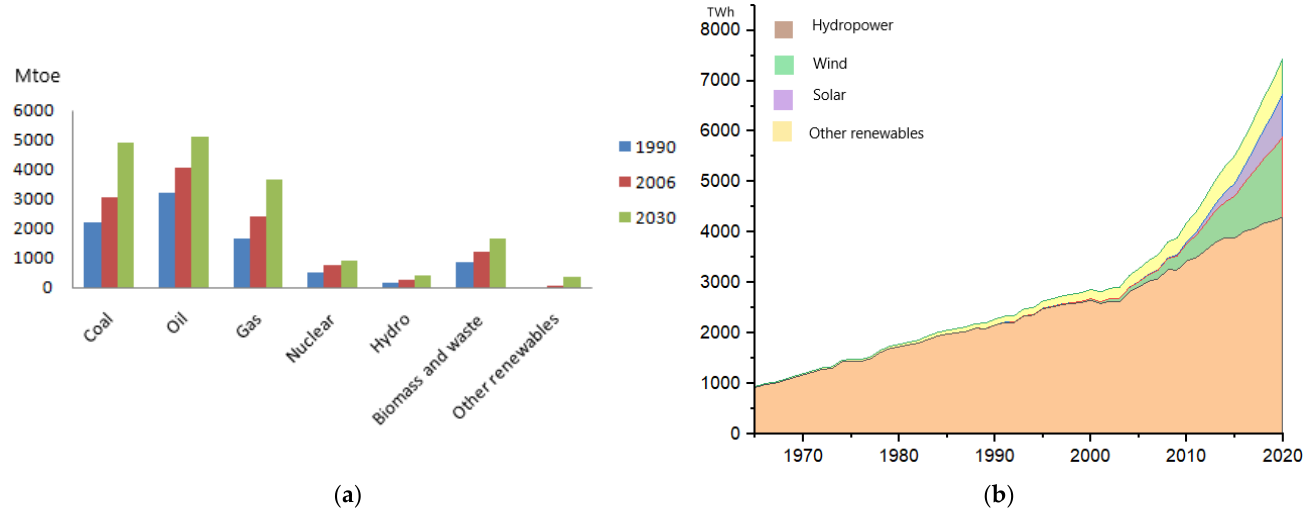
Figure 1. Renewable energy worldwide: ( a ) Global total primary energy consumption by fuel and ( b ) renewable energy generation worldwide. ( b ) renewable energy generation